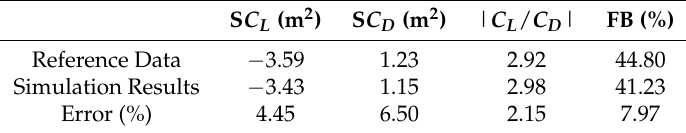
Table 3. Comparison between the simulation and reference data.